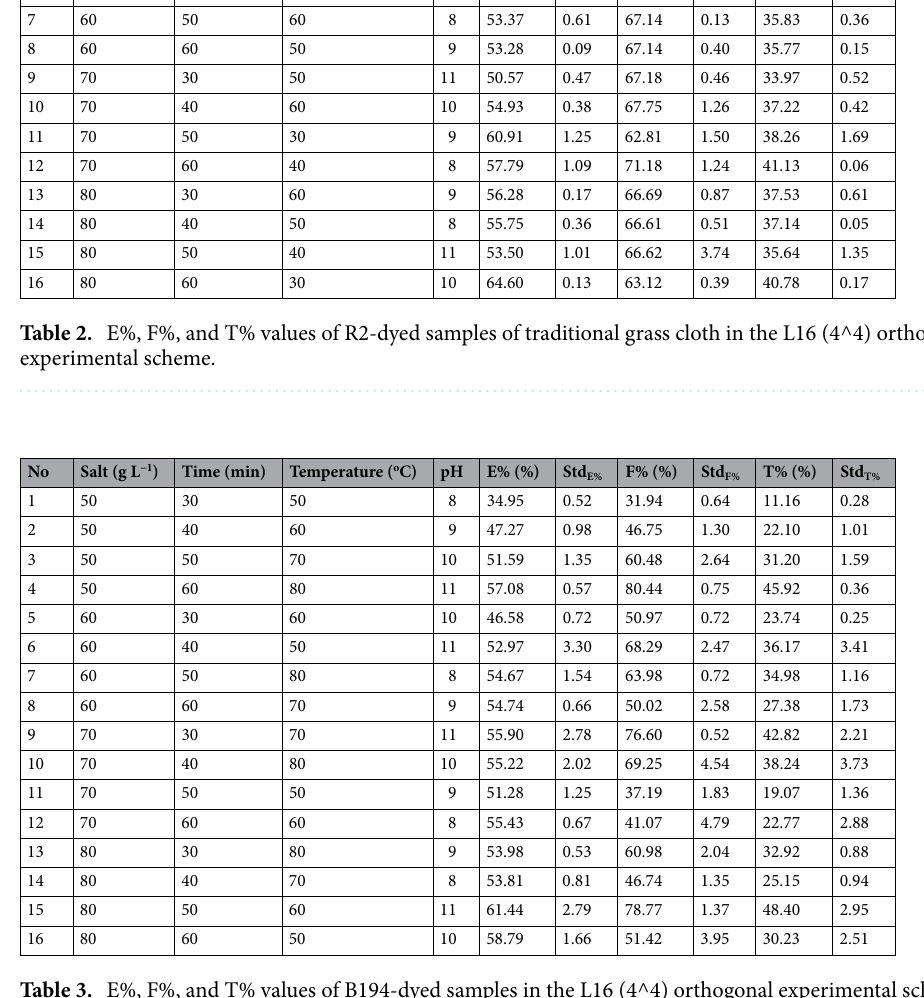
Table 3. E%, F%, and T% values of B194-dyed samples in the L16 (4^4) orthogonal experimental scheme.